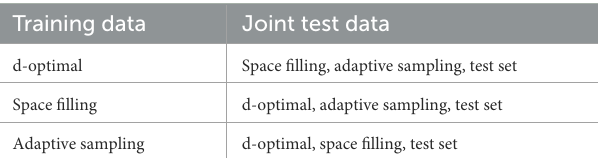
TABLE 2 Training and joint test data